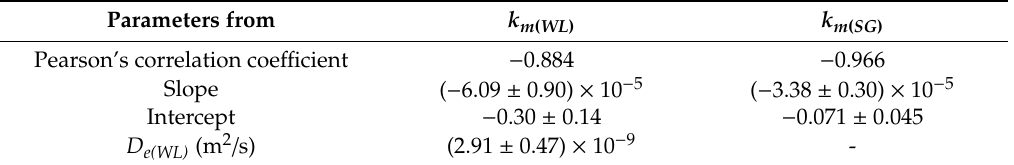
Table2. The e ff ective di ff usivitycoe ffi cients forwater lossand solidgain duringthe osmoticdehydration Table 2. The effective diffusivity coefficients for water loss and solid gain during the osmotic of courgette in CuSO 4 solution estimated from the analytical solution of Fick (cid:48) s equation. dehydration of courgette in CuSO 4 solution estimated from the analytical solution of Fick′s equation. Parameters from